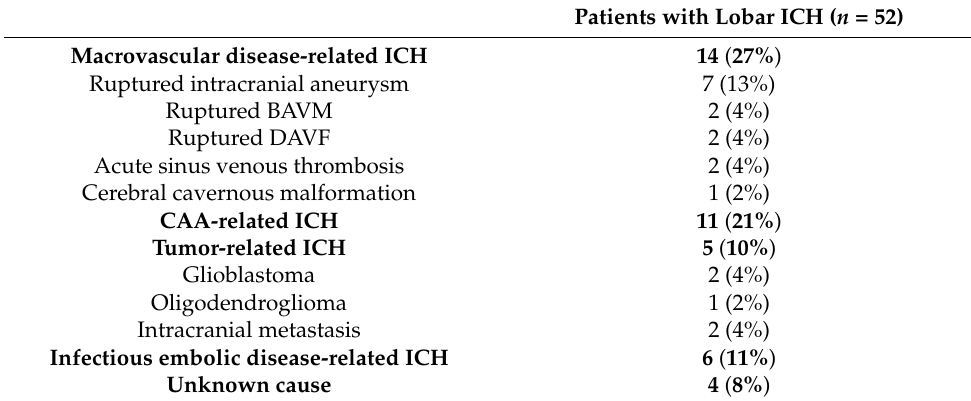
Table 2. Underlying pathology in patients with lobar